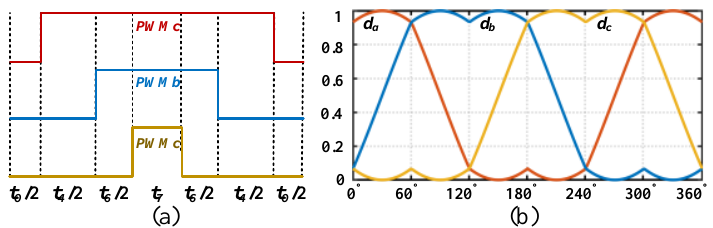
Figure 3. ( a ) The PWM signal in sector I. ( b ) The duty cycle in one